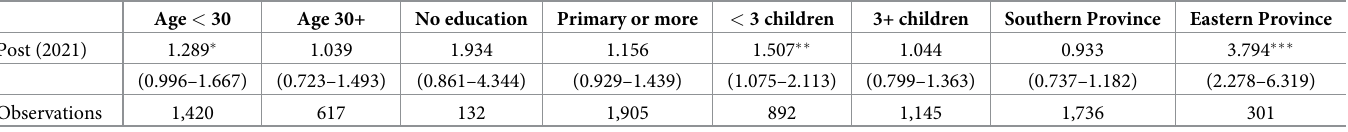
Table shows results of stratified logistic regression models. Displayed coefficients are odds ratios with 95% confidence intervals in parentheses. All models are fully adjusted (model specification 3 in Table 2) ��� p < 0.01, �� p < 0.05, � p <